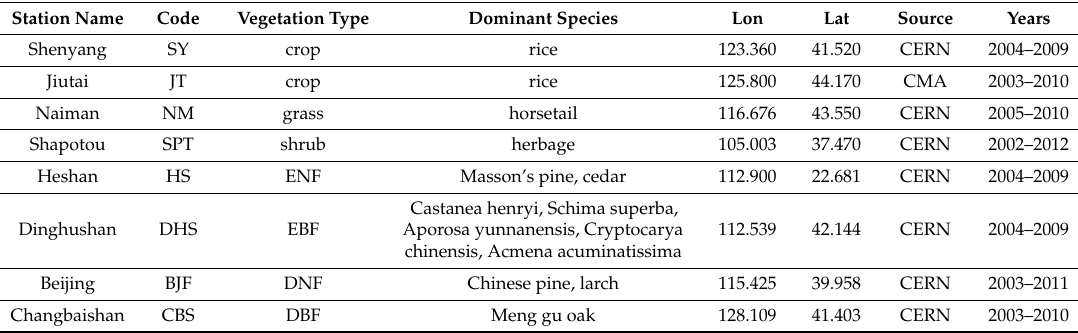
Table 1. Information for ground phenological observation sites in China.